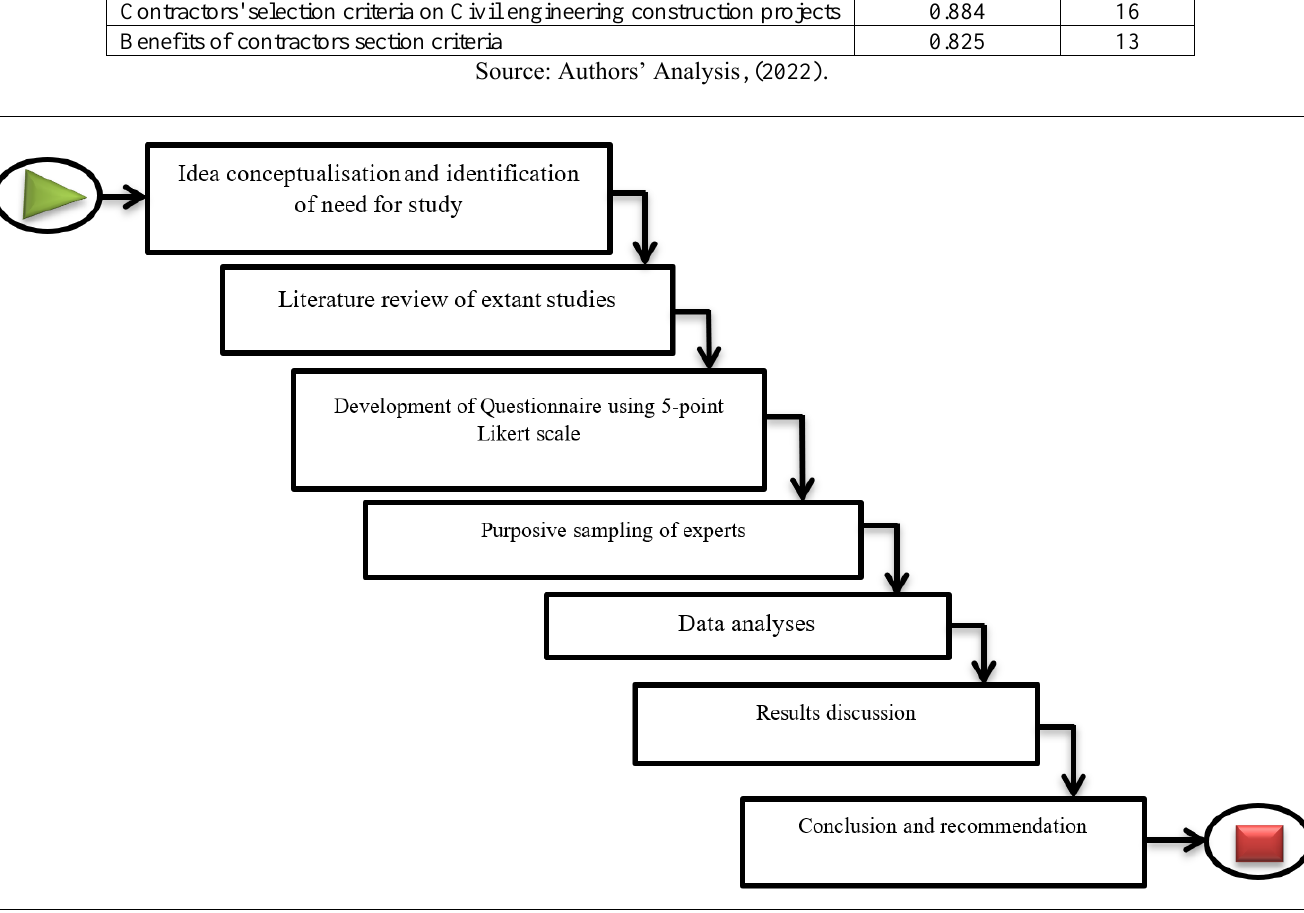
Table 4: Respondents' demographic